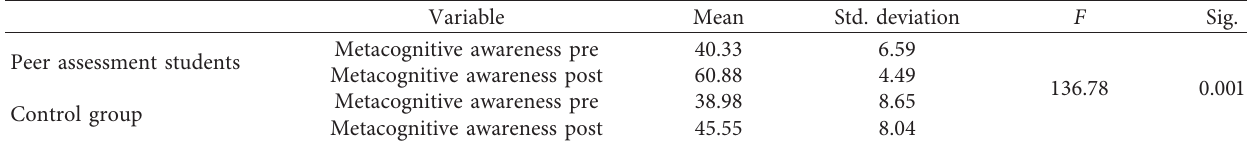
Table 5: Results of covariance for metacognitive awareness variable in peer-assessment group.